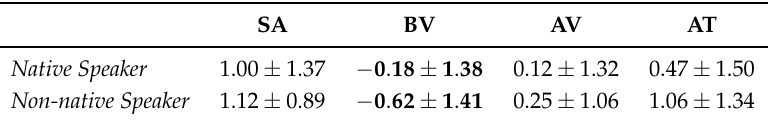
Table 2. Results of question whether expectations of subjects towards agents were met. Values are reported as mean ± standard deviation. (M ± SD). Negative values (indicating that expectations were not met) are denoted in bold . SA = Smartphone Application, BV = Basic Voice Agent, AV = Advanced Voice Agent, AT = Advanced Text Agent. BV AV AT